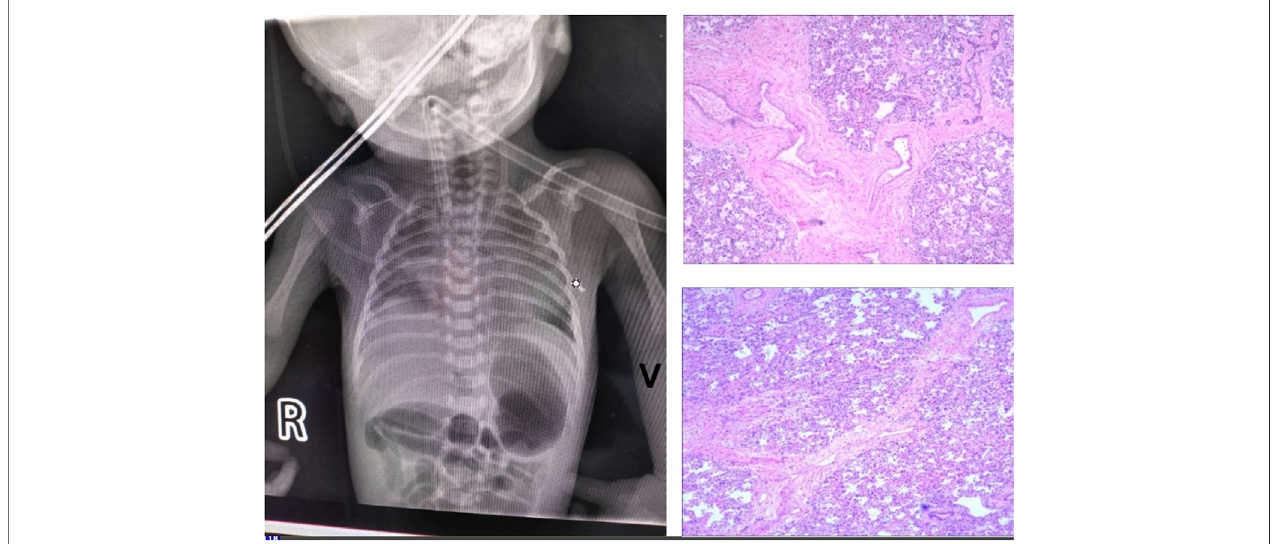
FIGURE 2 | Lung imaging. (A) Chest X-Ray showed massive pulmonary pleural effusions and hemorrhage. (B) HE staining showed diffusive interstitial fi brosis (*). magni fi cation of×100. (C) Histologic examinationsof thelung biopsy specimen demonstrated pulmonaryarteriovenousmalformations. There wasincreased number of blood vessels, some developing sac-like dilation and thickening walls (arrows).